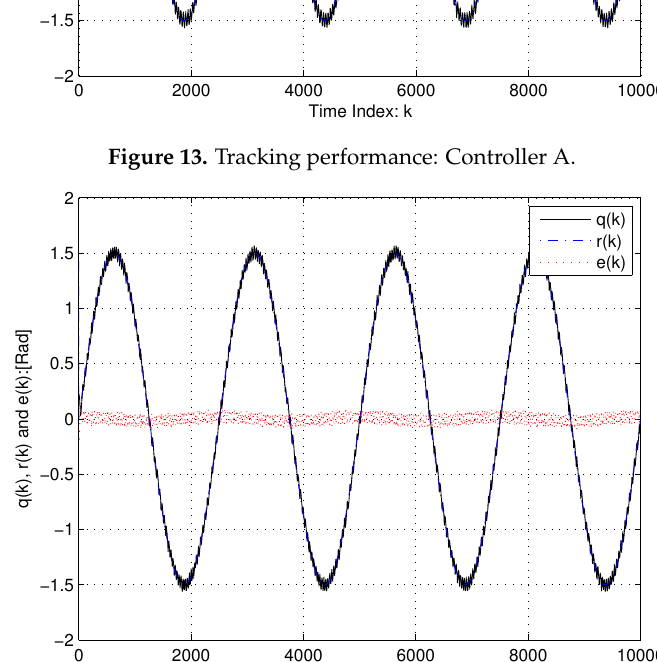
Figure 14. Tracking performance: Controller